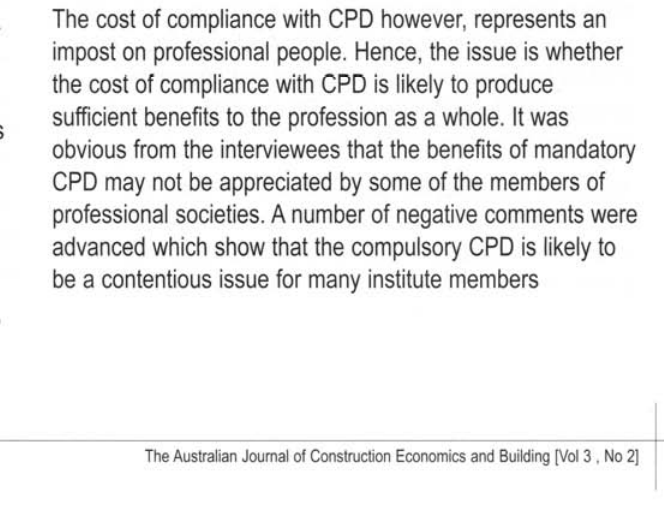
Table 2: Support for compulsory